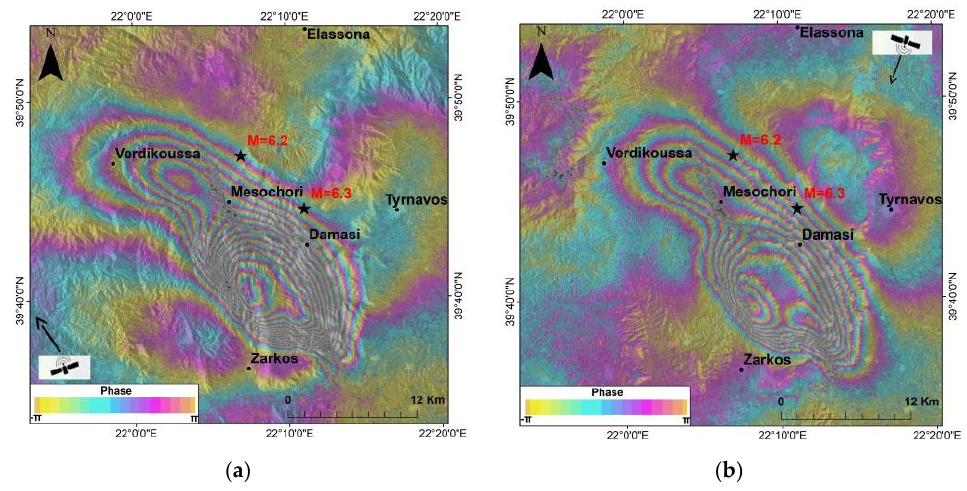
Figure 15. Wrapped interferograms for both the 3 and 4 March 2021 earthquakes: ( a ) ascending and ( b ) descending modes. Stars show the relocated epicenters; magnitudes according to our geodetic determinations.